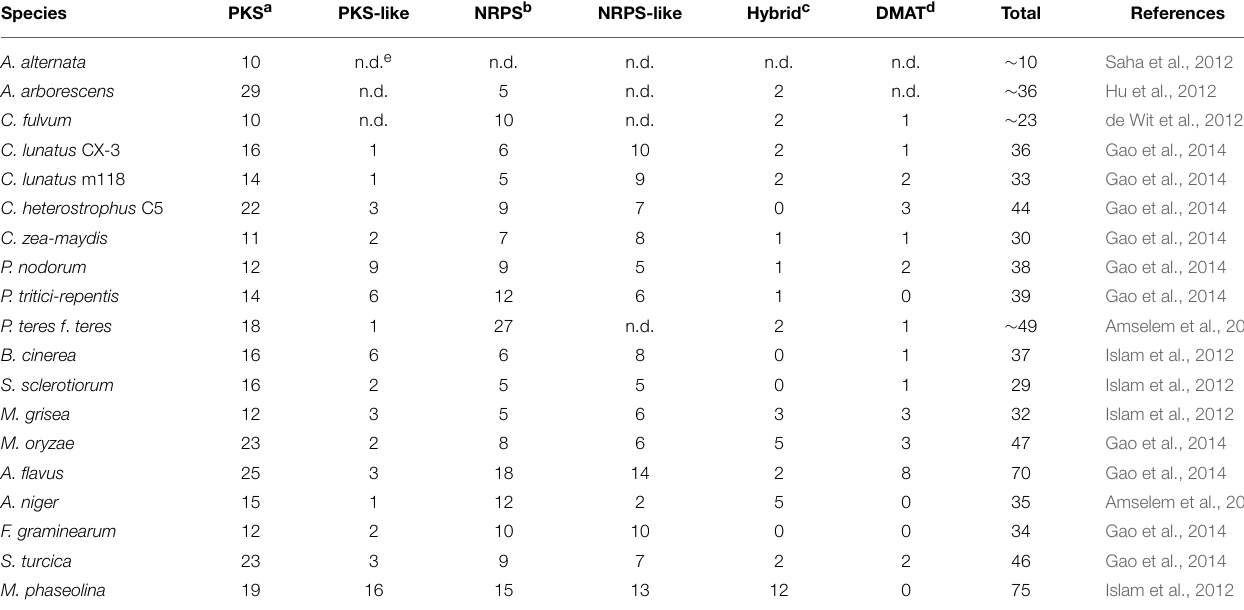
TABLE 1 | Distribution of secondary metabolite gene families in selected pathogenic fungi. Species PKS